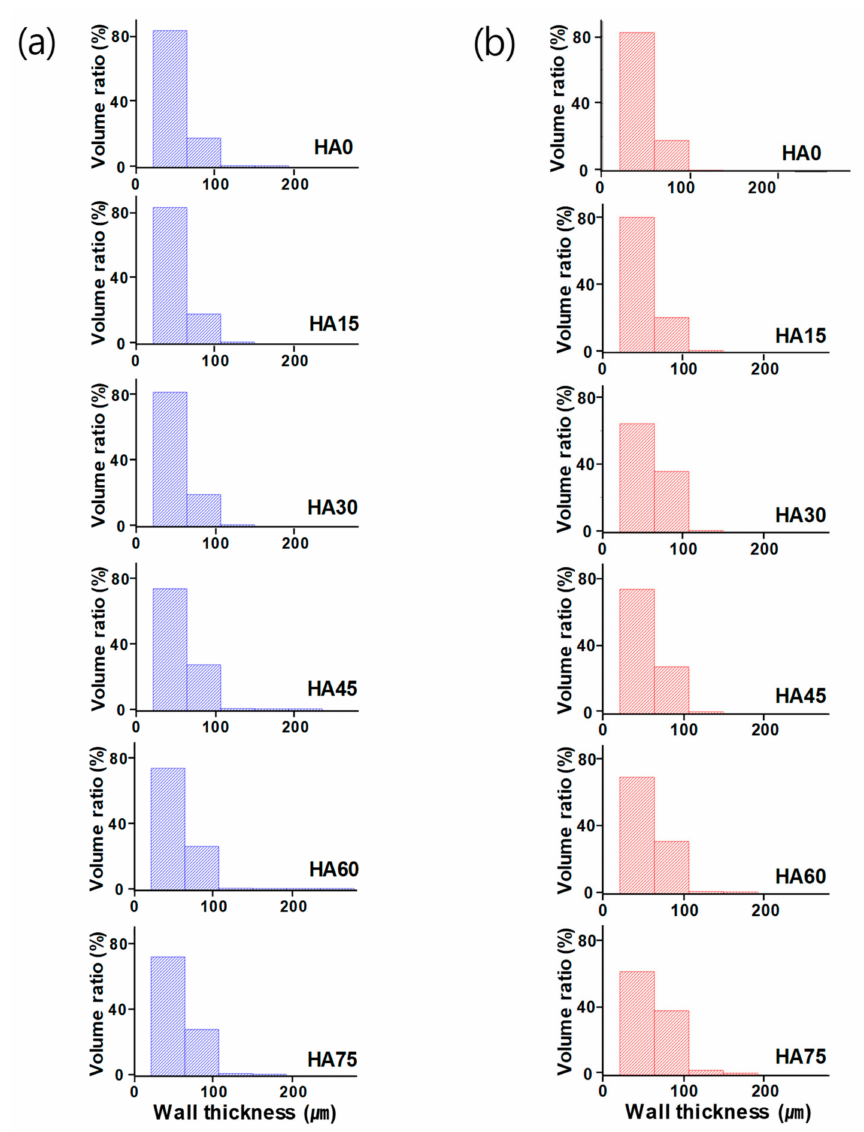
Figure 8. Wall thickness distribution of the sca ff olds with respect to the PMMA addition amount, before sintering and after